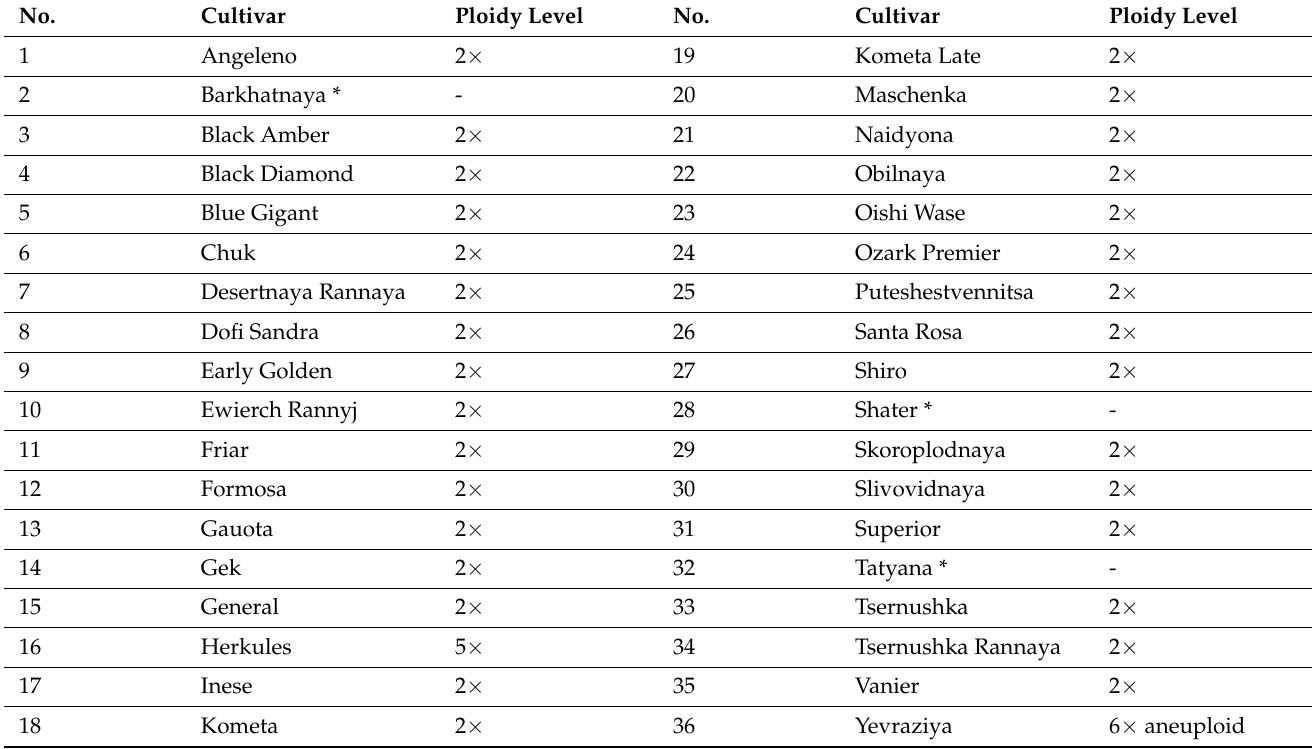
Table 4. Ploidy level evaluation of P. salicina cultivars using flow cytometry analysis.